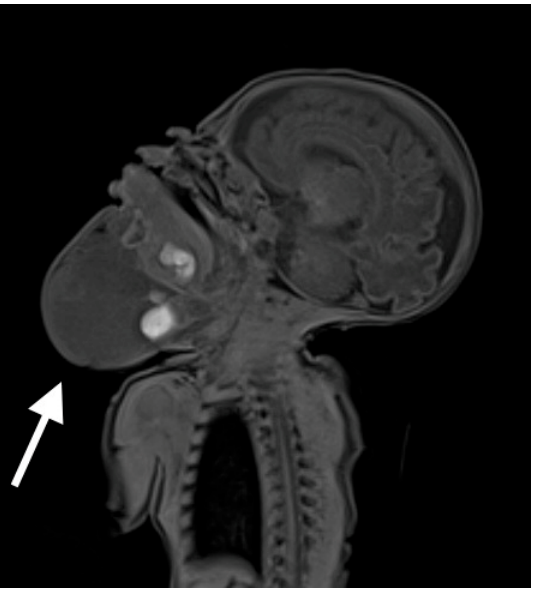
Figure 4. MRI scan on 6th day of life with visible cystic mass with approximate dimensions of cephalocaudal 10 cm × transverse 8 cm × anteroposterior 6.5 cm.